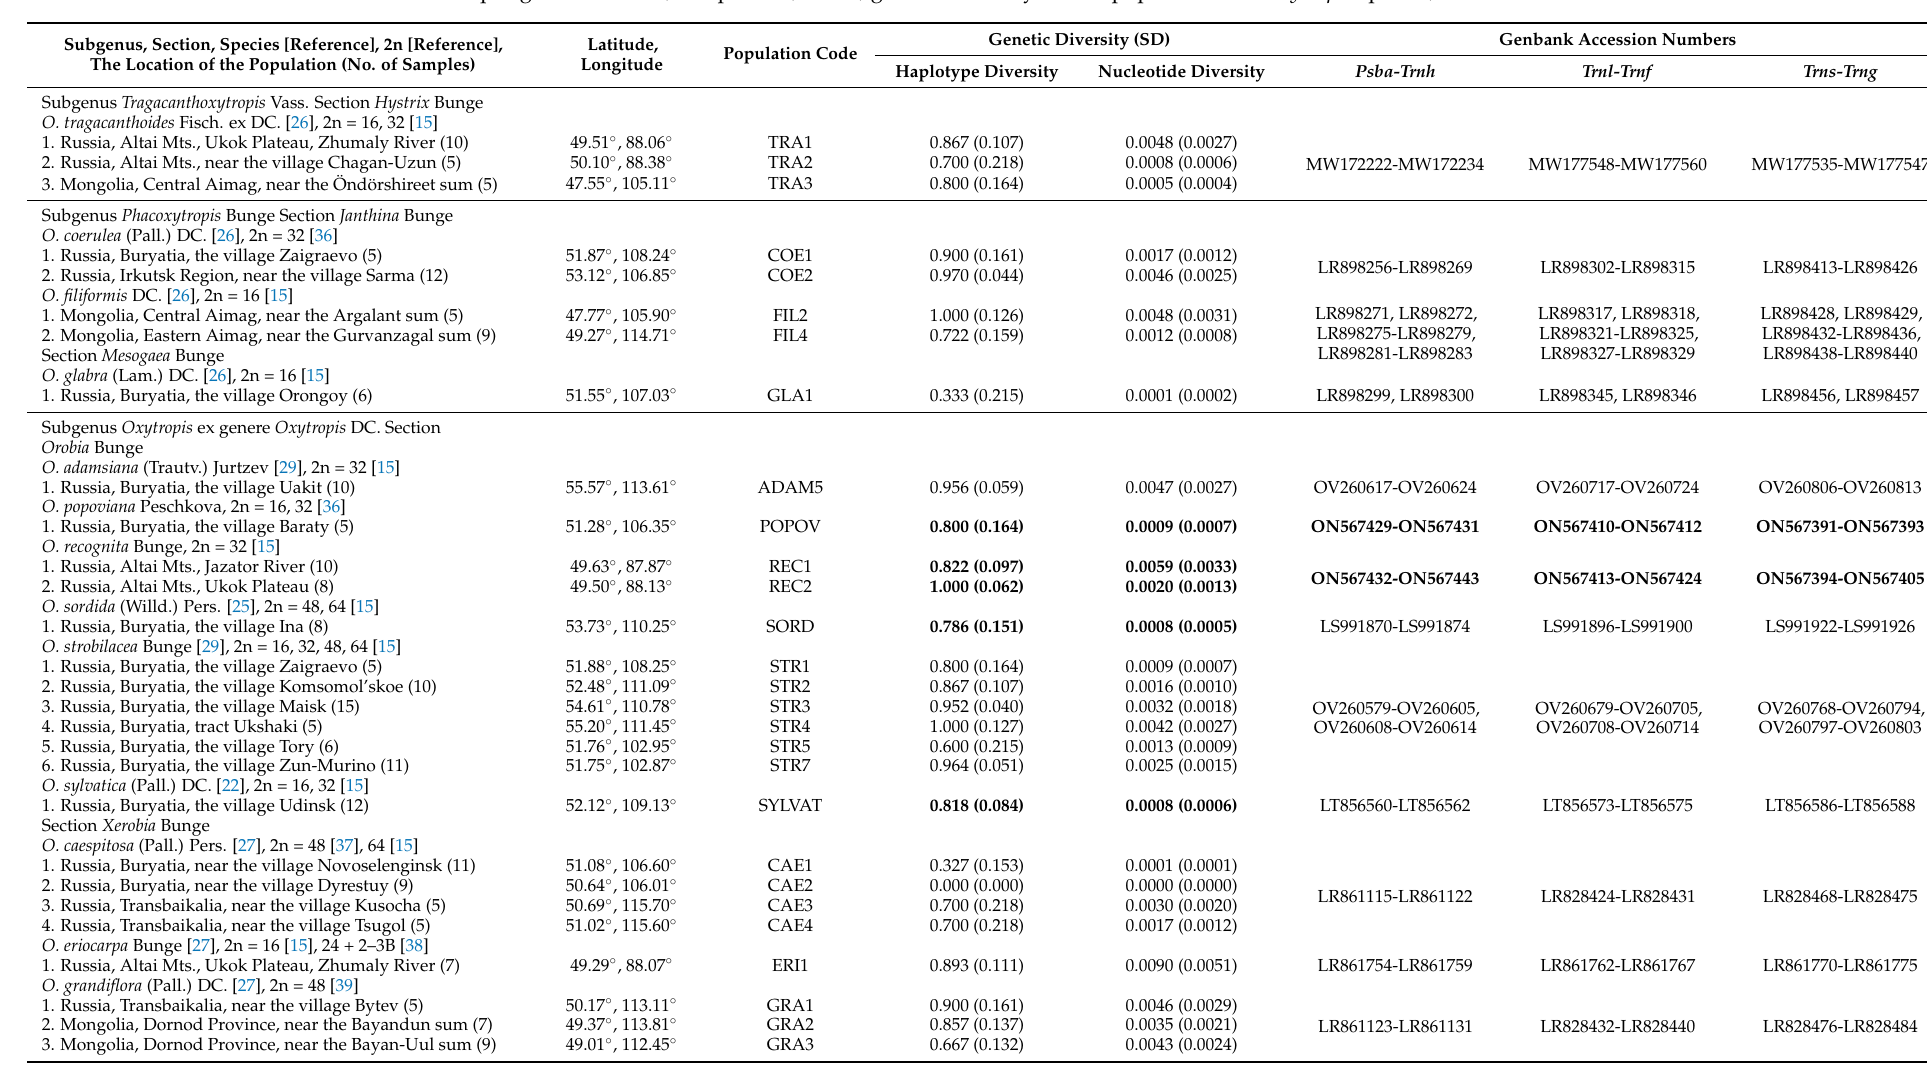
Table 1. Sampling site locations, sample size, codes, genetic diversity within populations of Oxytropis species, and GenBank accession